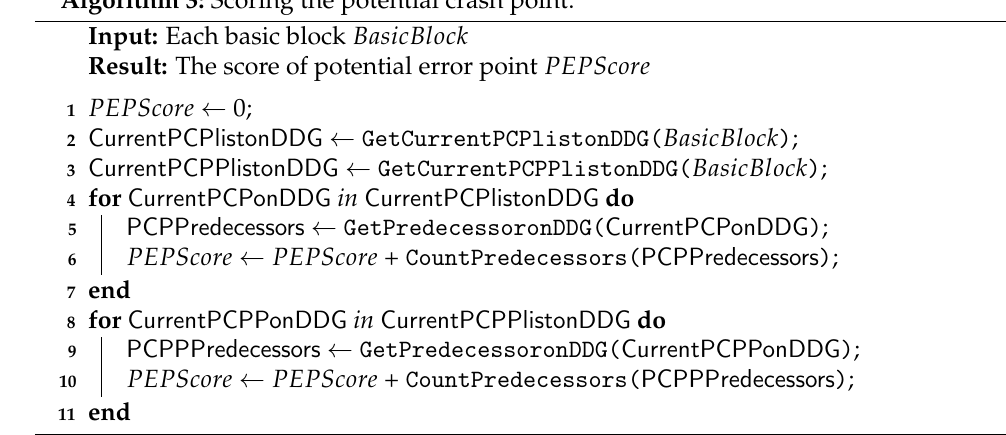
Algorithm 3: Scoring the potential crash